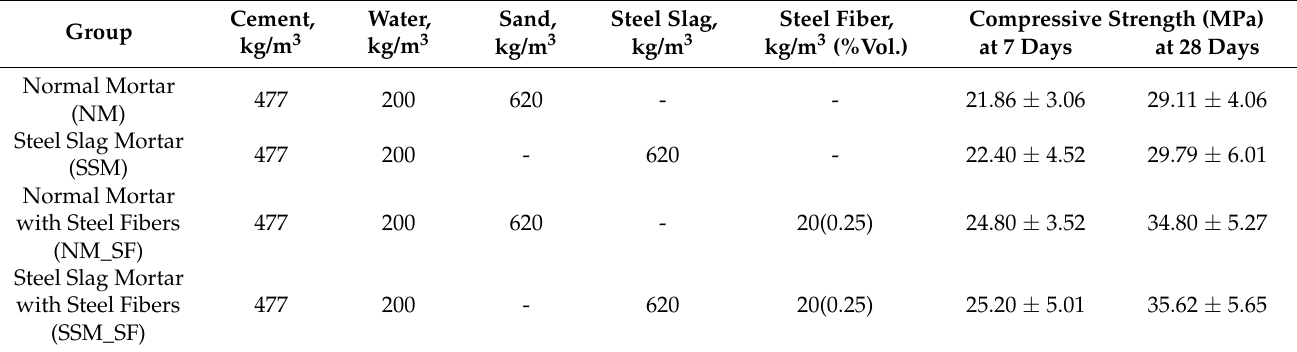
Table 1. Mix proportions and compressive strengths of